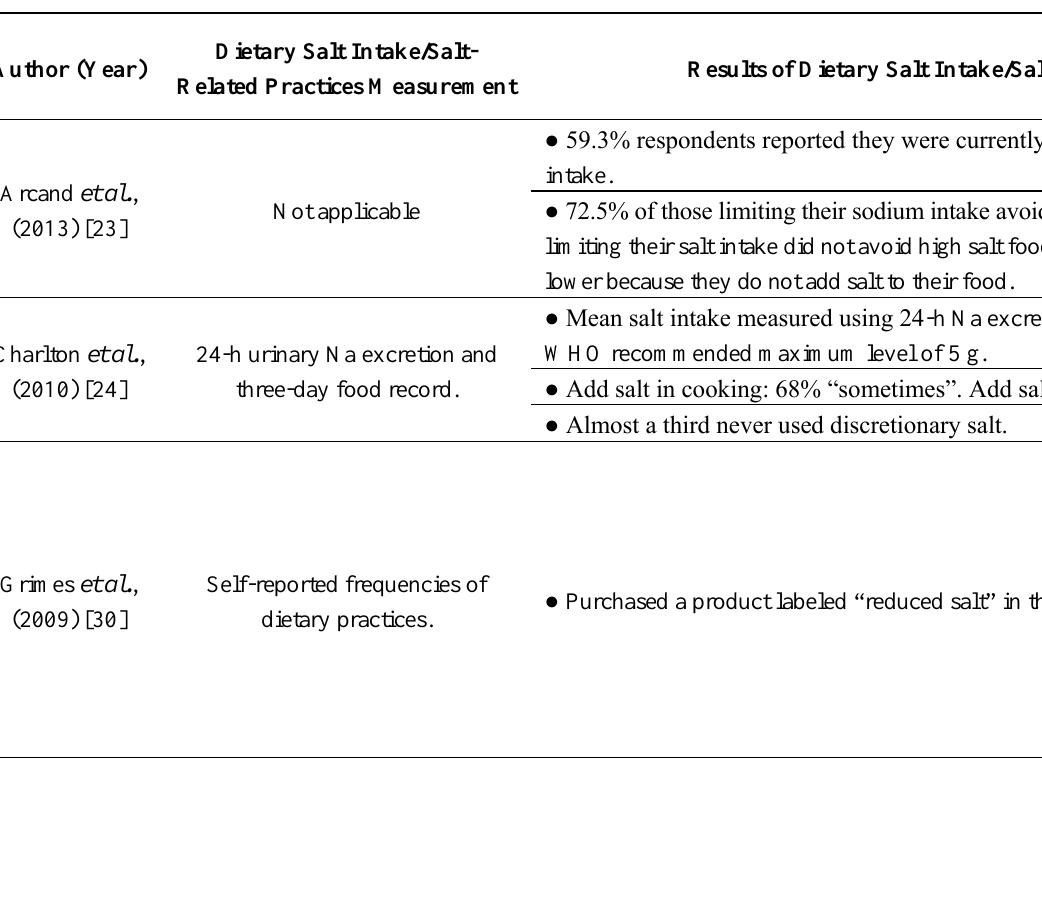
Table 4. Summary of relationships between salt knowledge and salt intake/salt-related dietary